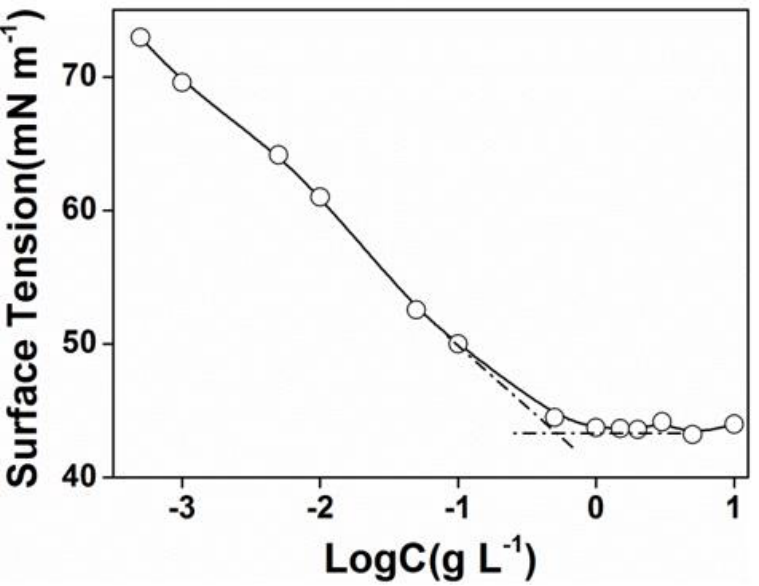
Figure 2. Plots of surface tension versus Log C for PEG- acrylic rosin polymer aqueous solutions at 25 °C.